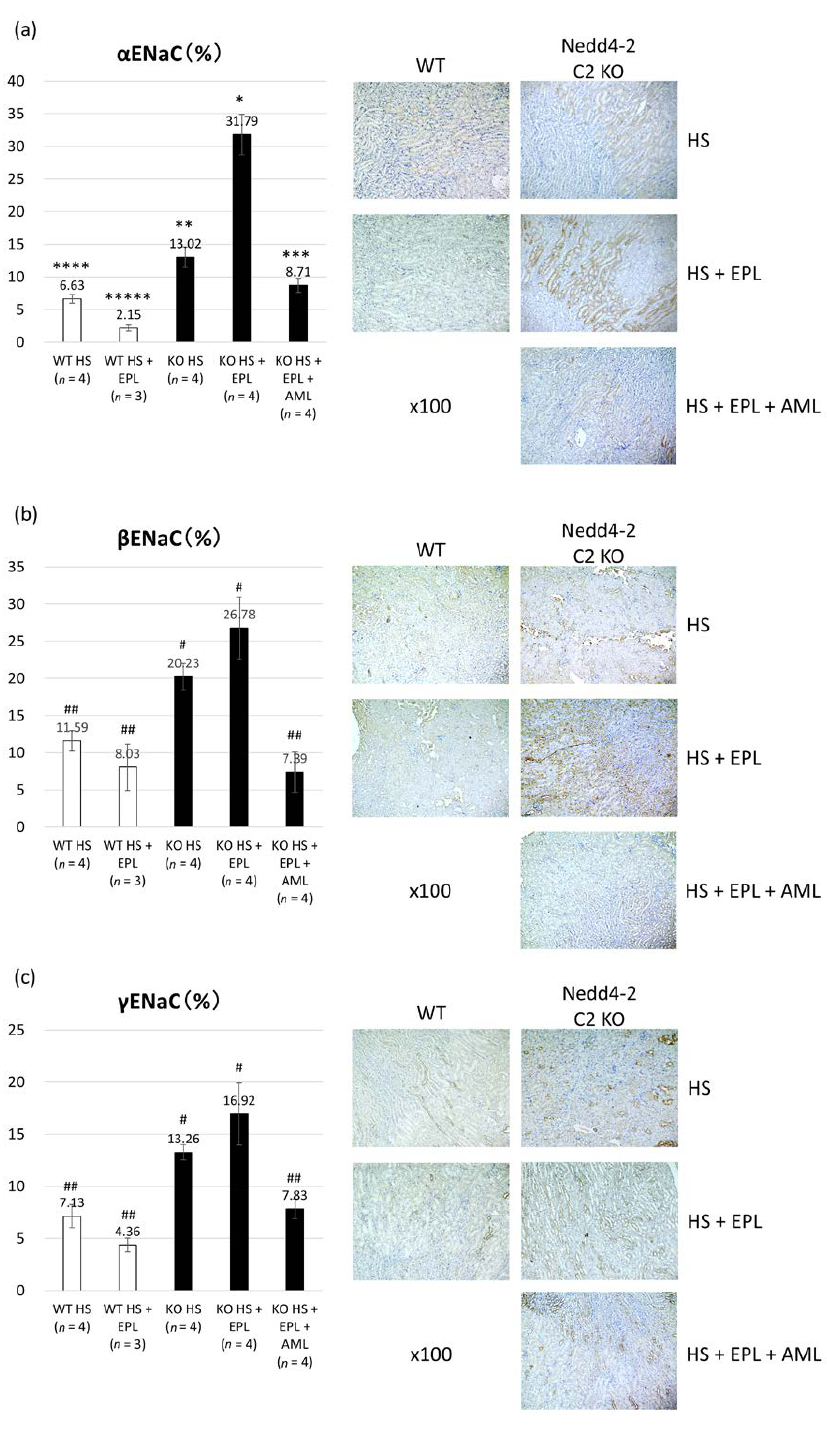
Figure 5. Immunostaining of ( a ) α ENaC; ( b ) β ENaC; and ( c ) γ ENaC proteins